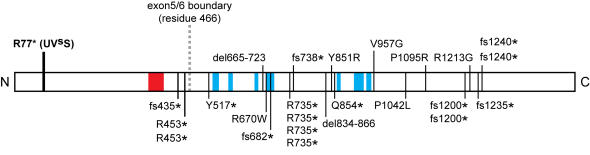
Schematic of CSB Mutations Associated with Human Disease.Of 24 patients with known CSB geneotypes and CS, COFS, or XP-DSC phenotypes, 21 have at least one allele that is predicted to express intact CSB-PGBD3 fusion protein. For each patient, the allele with the more C-terminal mutation is shown (e.g. patient CS1AN is a compound heterozygote for K337STOP and del834-866; only the latter is shown here). Some mutations are found in several patients. The location of the homozygous UVsS mutation that causes UV sensitivity but not CS [33] is shown for comparison. See Table S1 for a list of all patients and alleles. fs, frameshift; del, deletion; *, STOP. Red box is the CSB acidic domain; blue boxes are the ATPase subdomains.